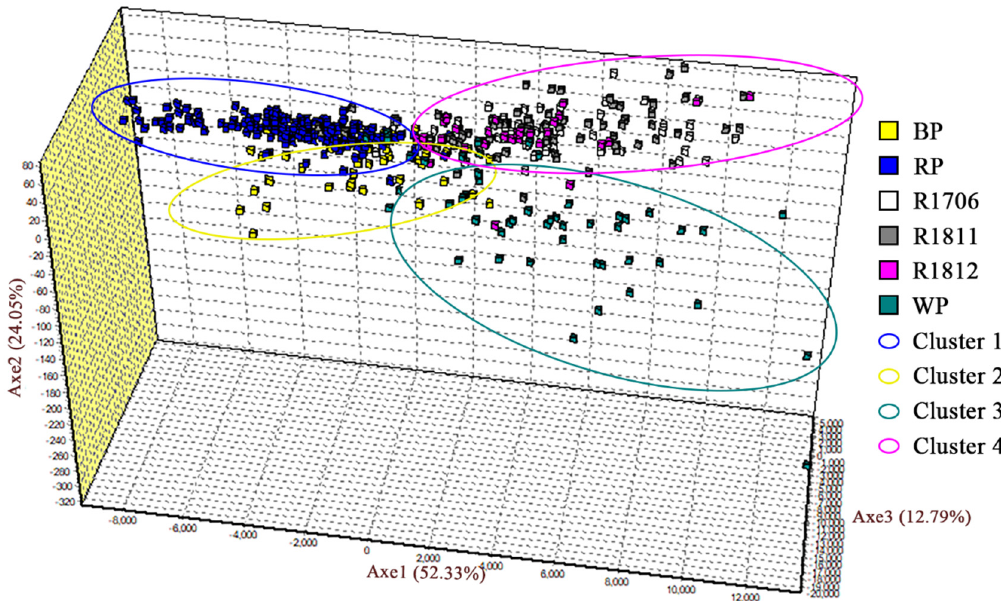
Figure 2. FCA result of six black sea bream populations, which divided them into four clusters.